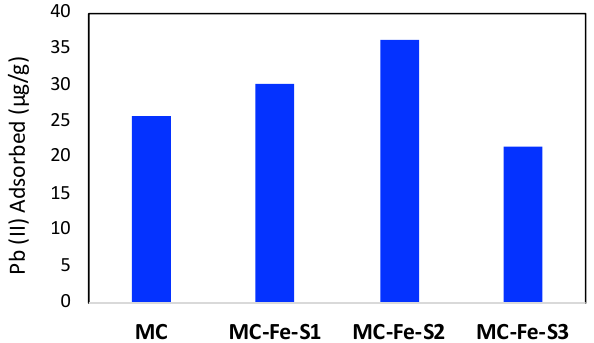
Figure 6. Pure Pb (II) adsorption data in pure mesoporous carbon (MC) and iron and sulfur dual-doped mesoporous carbons. All the experiments were performed in batch mode in 25 mL 100 ppb ( µ g / L) Pb(II) and 0.025 g adsorbent (Adsorbent concentration 1 g / L).